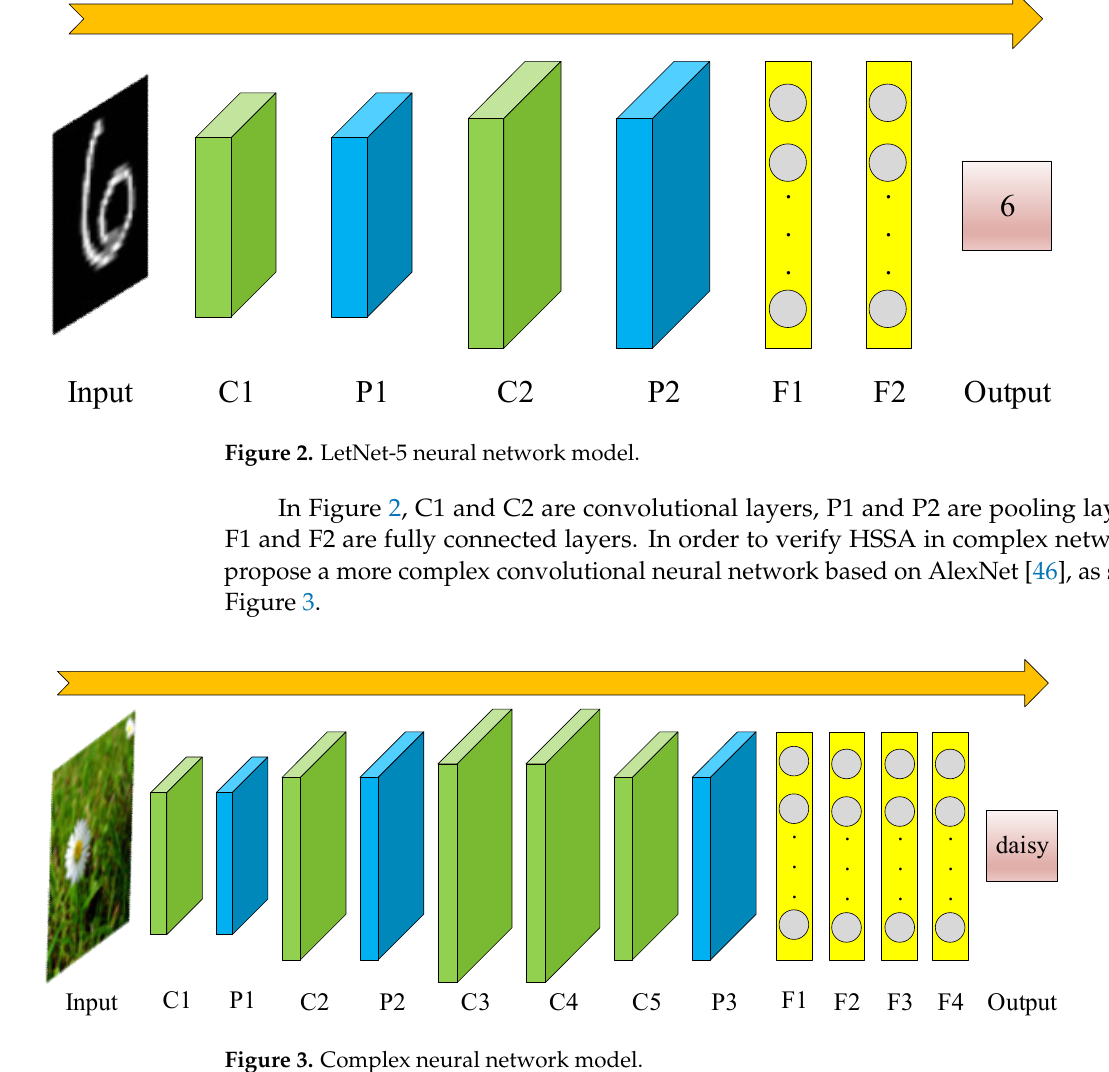
Figure 3. Complex neural network model.